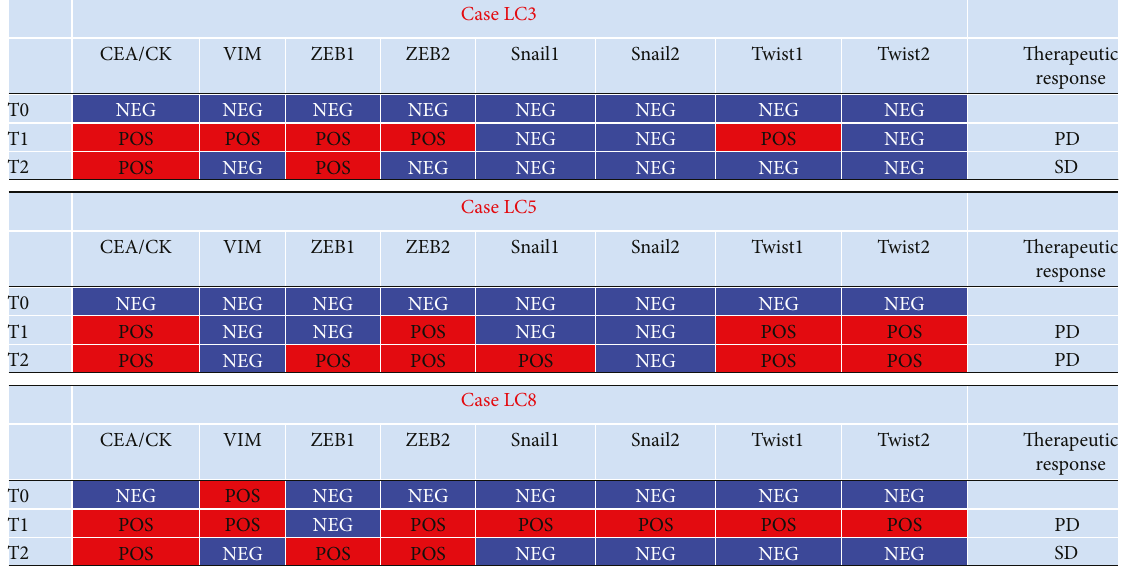
Figure 6: Dynamic variations of CTC molecular pro fi le in still living patients at T1 and T2 evaluation with respect to clinical outcomes and therapeutic response (SD: stable disease, PD: progression